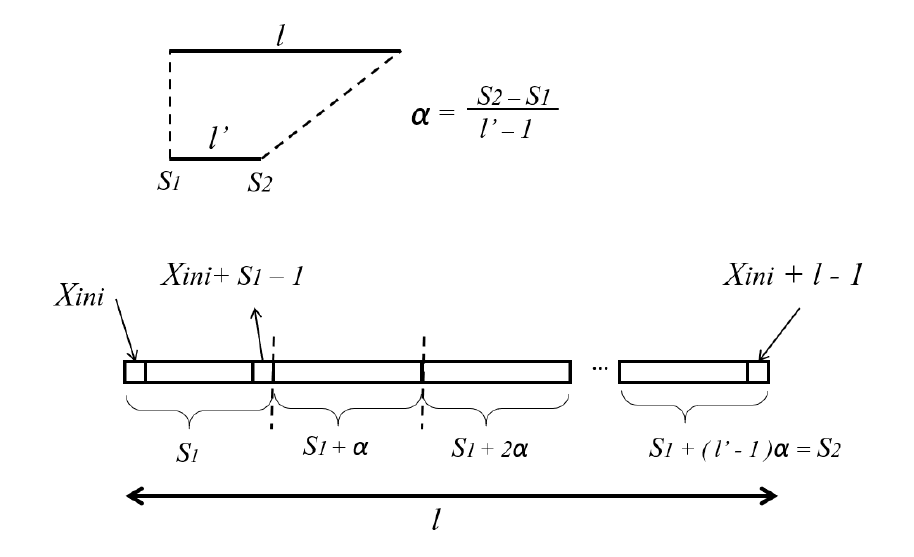
Figure 6. Arithmetic series for elastic